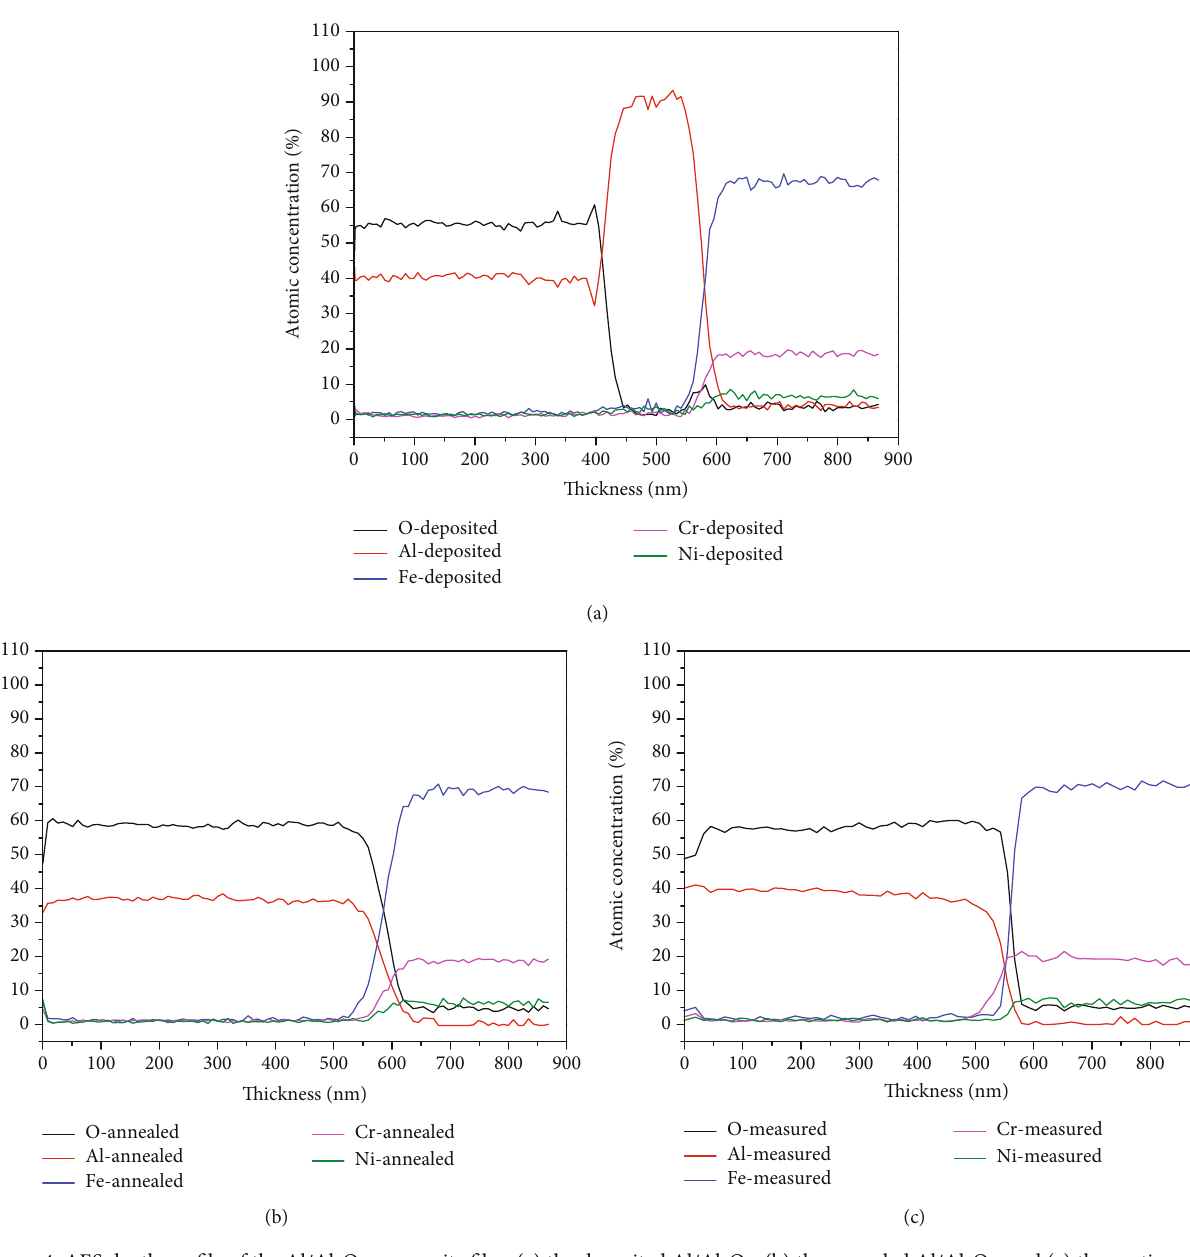
O composite fi lm: (a) the deposited Al/Al 2 3